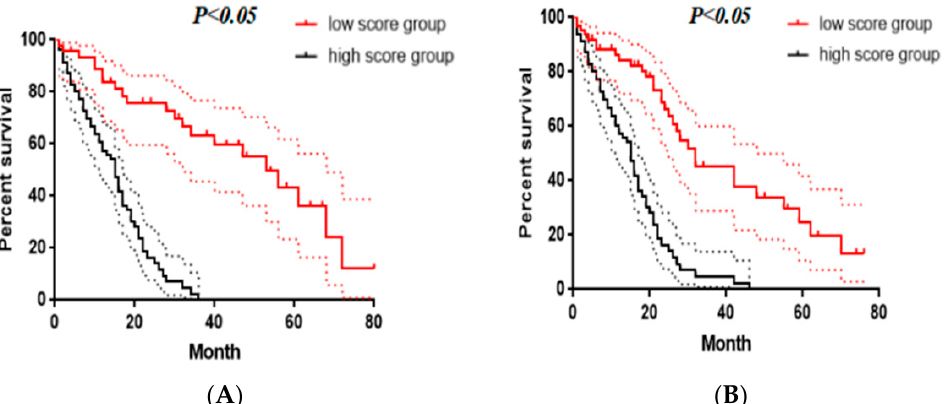
Figure 7. Kaplan – Meier survival curves for overall survival (OS) of patients according to the nom ‐ Figure 7. Kaplan–Meier survival curves for overall survival (OS) of patients according to the ogram ‐ II ‐ based subgroups in the training set ( A ) and validation set ( B ). nomogram-II-based subgroups in the training set ( A ) and validation set ( B